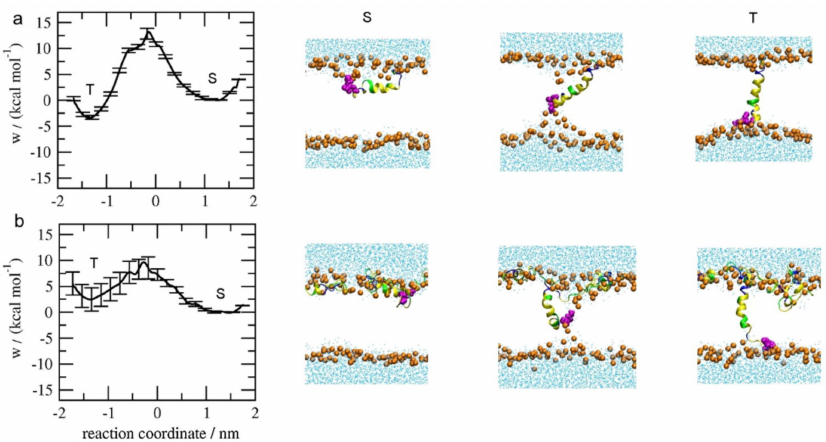
Figure 5. Potential of mean force (PMF) distribution during insertion of the first peptide into membranes with di ff erent peptide concentrations. ( a ) P/L = 1/128; ( b ) P/L = 4/128. The first three residues at the N-terminus are colored in magenta. The figure is reprinted with permission from [89], copyright 2013, American Chemical